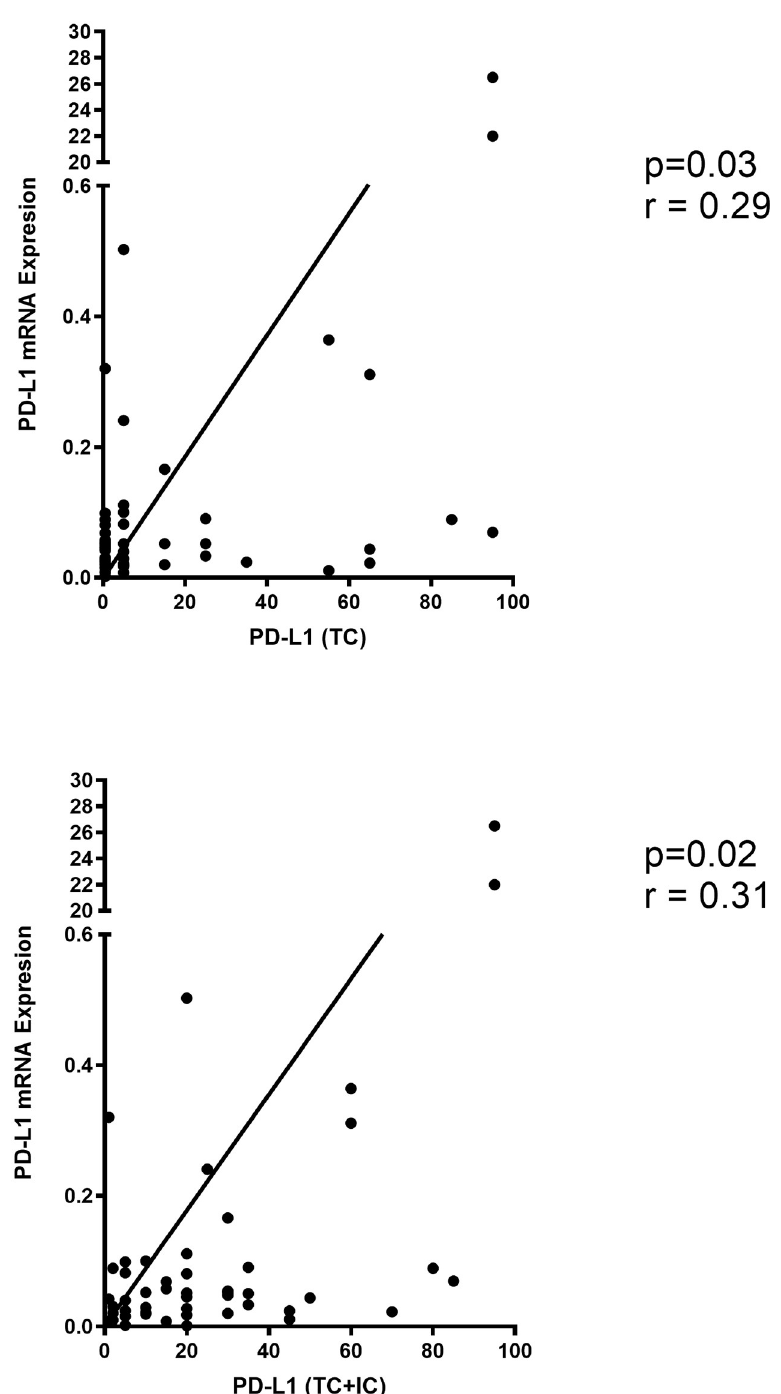
Fig 2. PD-L1 expression by IHC correlates with PD-L1 mRNA expression by qPCR. A total of 49 fresh lung tumors were evaluated for PD-L1 expression by IHC and quantified for PD-L1 mRNA by RT-qPCR. PD-L1 expression was evaluated on tumor cells only (TC), and on both tumor and immune cells (TC+IC). (A) PD-L1 expression on tumor cells (IHC) is significantly correlated with PD-L1 mRNA expression (qPCR). (B) Also, PD-L1 expression tumor and immune cells (IHC) is significantly correlated with PD-L1 mRNA expression (RT-qPCR).